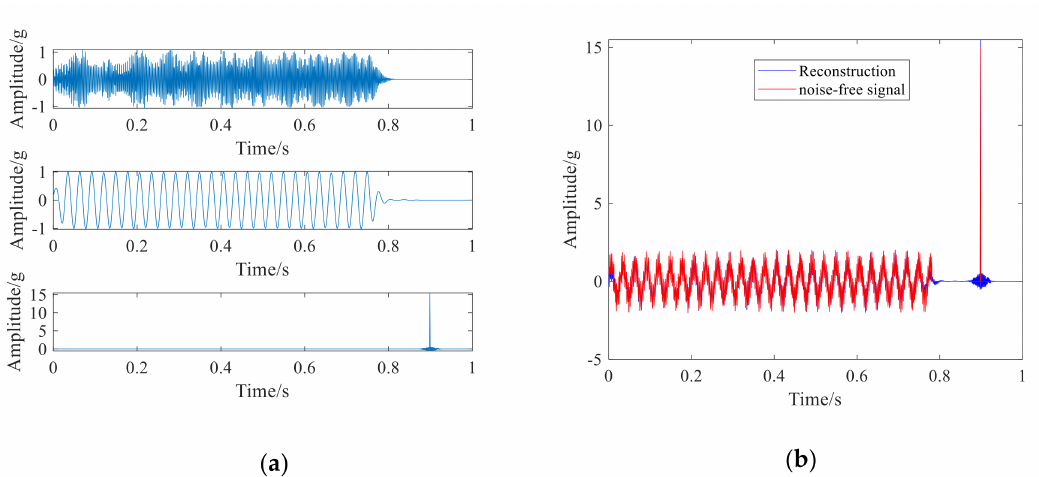
Figure 5. Performance of signal decomposition and reconstruction by proposed method. ( a ) multi- components signal decomposition. ( b ) signal reconstruction.